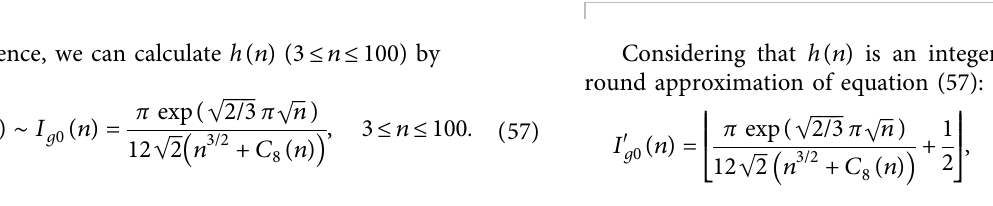
( n ) when 1000 ≤ n ≤ 10000, step 7 b